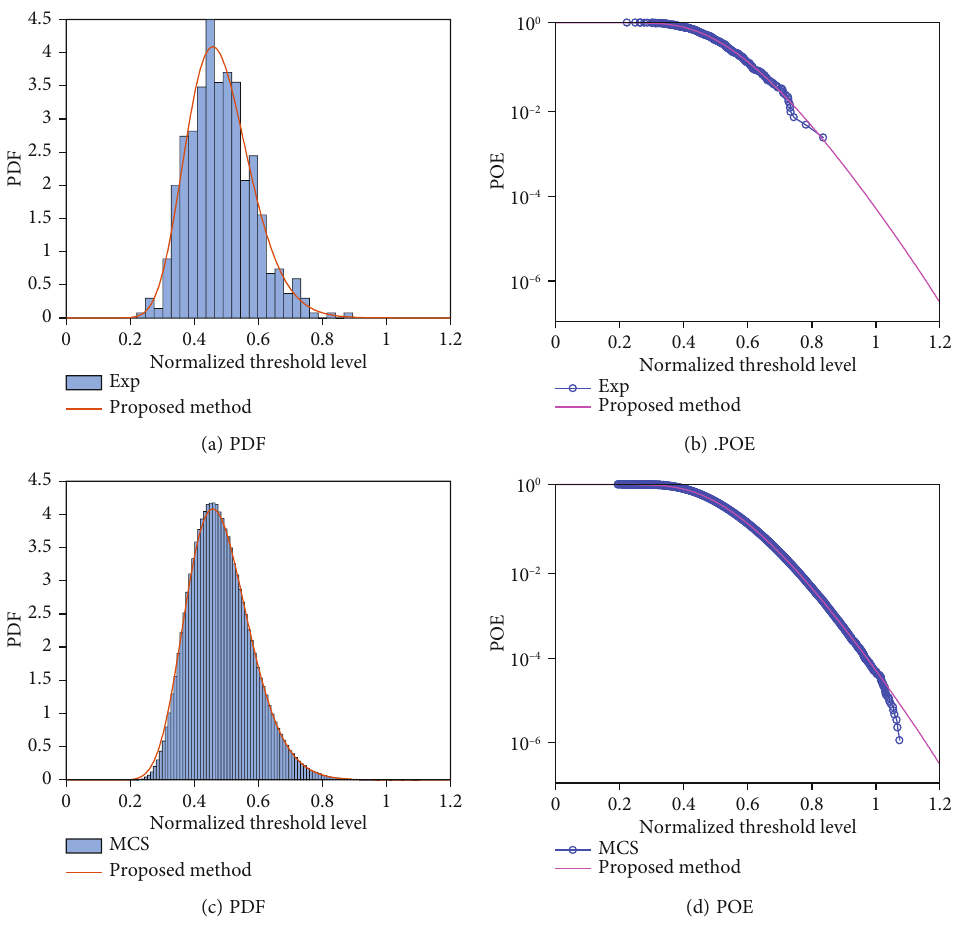
Figure 4: Comparison of histogram, PDF, and POE for m = 3 and N = 500